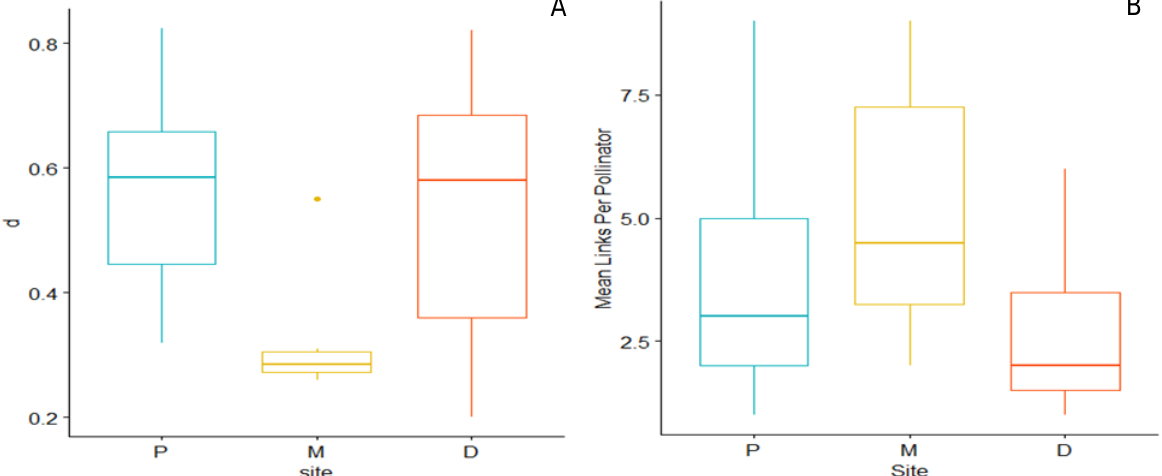
F IGURE 6: Box plot showing (A) species- level specialization (d’), and ( B) mean links per pollinator for Hymenopteran pollinators between the three sites. P=Pristine; M=Late Successional; D=Early Successional. P is significantly different to M at P <